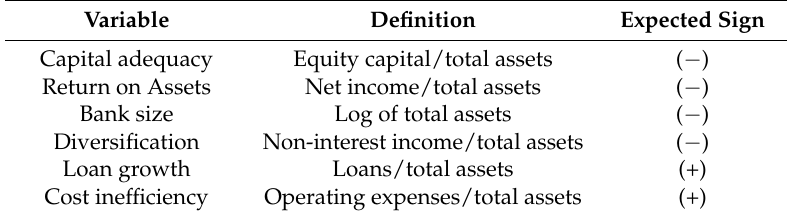
Table 1. Banking management variables and their expected relation to non-performing